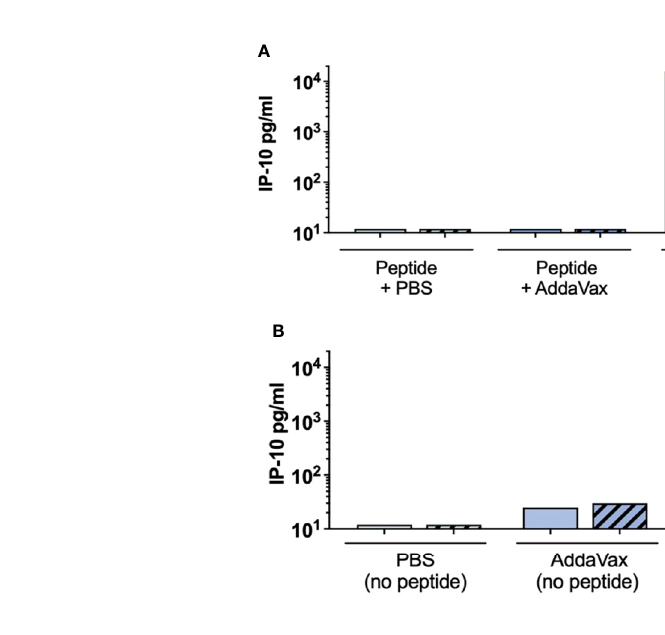
FIGURE 5 | IP-10 (CXCL10) in serum 4h and 24h post SS with AddaVax + Resiquimod + CpG. ELISA quantitation of chemokine IP-10 (CXCL10) in serum of mice immunized by SS either with CS peptide (A) or without peptide (B) . IP-10 concentrations (pg/ml) were measured in serum collected at 4h (solid bars) or 24h (hatched bars) post SS prime.